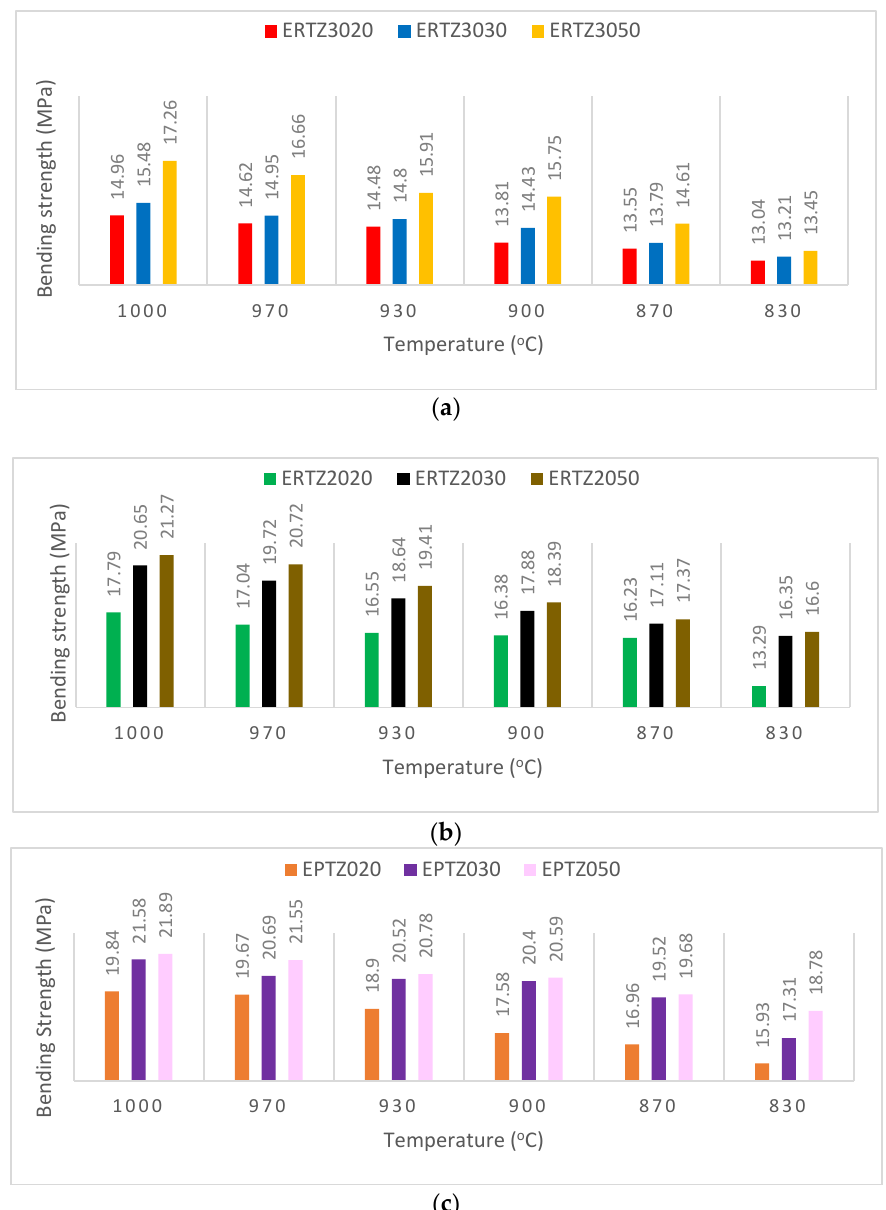
Figure 9. ( a ) Bending strength for mixtures with 30% expanded perlite in 6 different peak tempera- tures, ( b ) Bending strength for mixtures with 20% expanded perlite in 6 different peak temperatures and ( c ) Bending strength for mixtures without expanded perlite in 6 different peak tempera- tures.